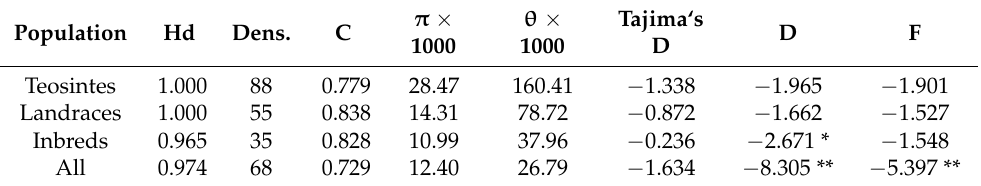
Table 2. ZmCKX5 genetic diversity analysis and neutral test between teosintes, landraces, and in- bred lines. Dens.